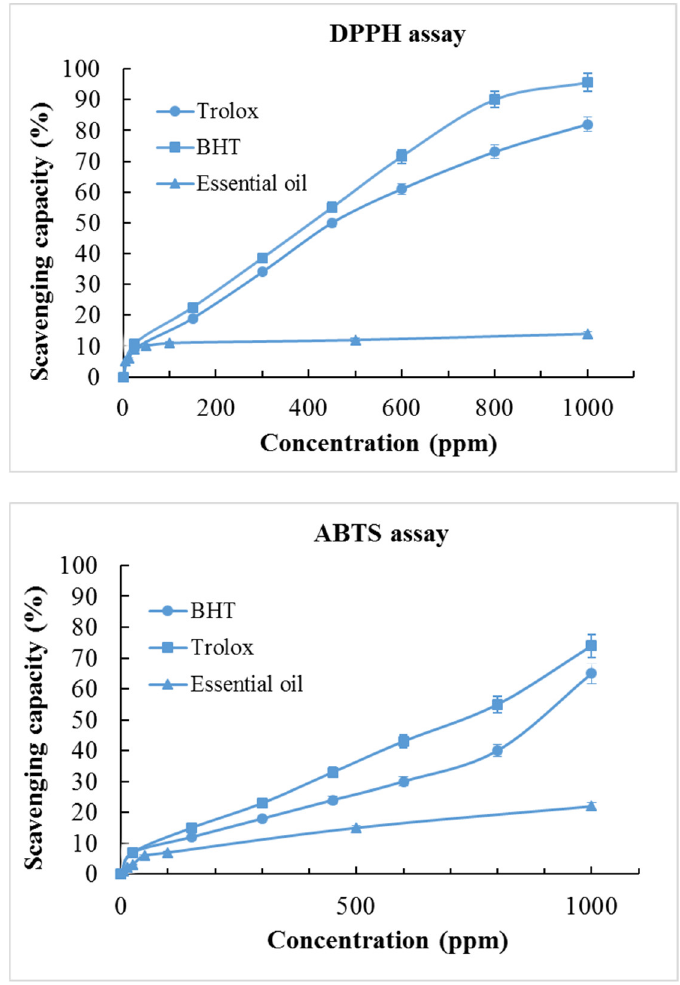
Figure 1. Antioxidant activity of Piper carpunya essential oil.